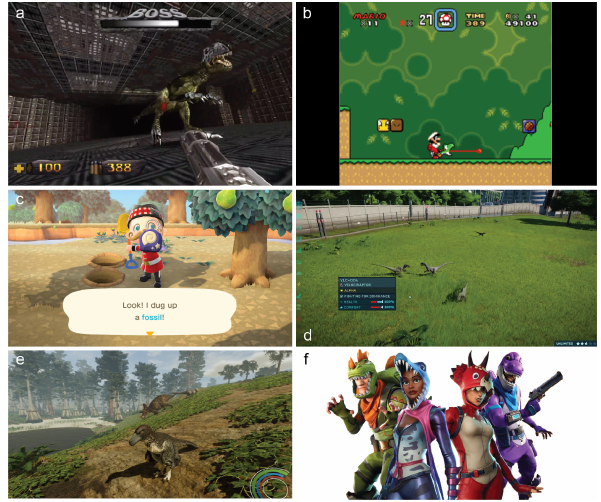
Figure 3. Screenshots of COTS video games that represent the 5 categories of palaeontological video games outlined in this paper. (a) Ancient animals as adversaries. The player is fighting a cyber- netically enhanced Tyrannosaurus armed with laser-shooting ocular augments and fire breath in Turok: Dinosaur Hunter (1997, Iguana Entertainment). (b) Ancient animals as tools. Mario riding Yoshi in Super Mario World (1990, Nintendo EAD). (c) Fossils as col- lectibles. The player discovers a fossil in Animal Crossing: New Horizons (2020, Nintendo EAD). (d) Ancient animal management simulators. A paddock of Velociraptor exhibiting modelled in-game behaviours (the alpha is fighting for dominance of the pack). Juras- sic World: Evolution (2018, Frontier Developments). (e) Ancient animal simulators. The player’s avatar, a Dakotaraptor , sits near a water body while Triceratops and Pachycephalosaurus graze in the background. Saurian (2017, Urvogel Games, LLC). (f) Examples of cosmetic items that are based on ancient animals from Fortnite (2017, Epic Games) – often these only change the players charac- ter models (and not core gameplay mechanics) and are known as